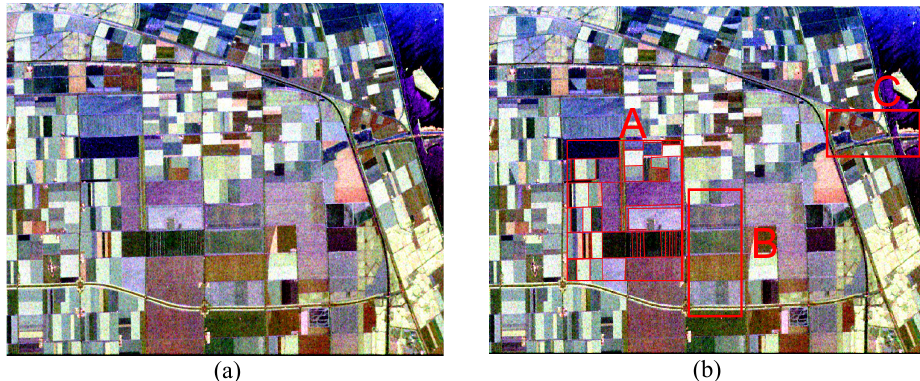
Figure 6. AIRSAR data set. ( a ) Pauli-RGB image. ( b ) Ground-truth map of region A.